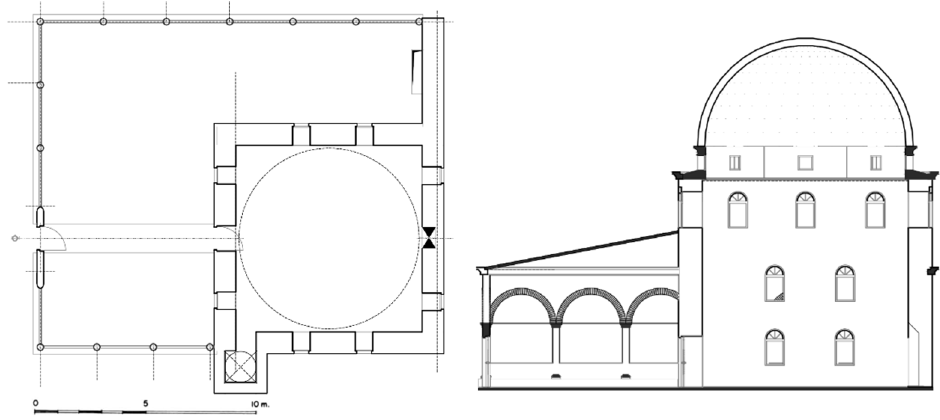
Figure 9. Plan layout ( left ) and section ( right ) of the Et’hem Bey Mosque in Tirana. Provision courtesy from Arch. Arsim Murseli, UBT University.